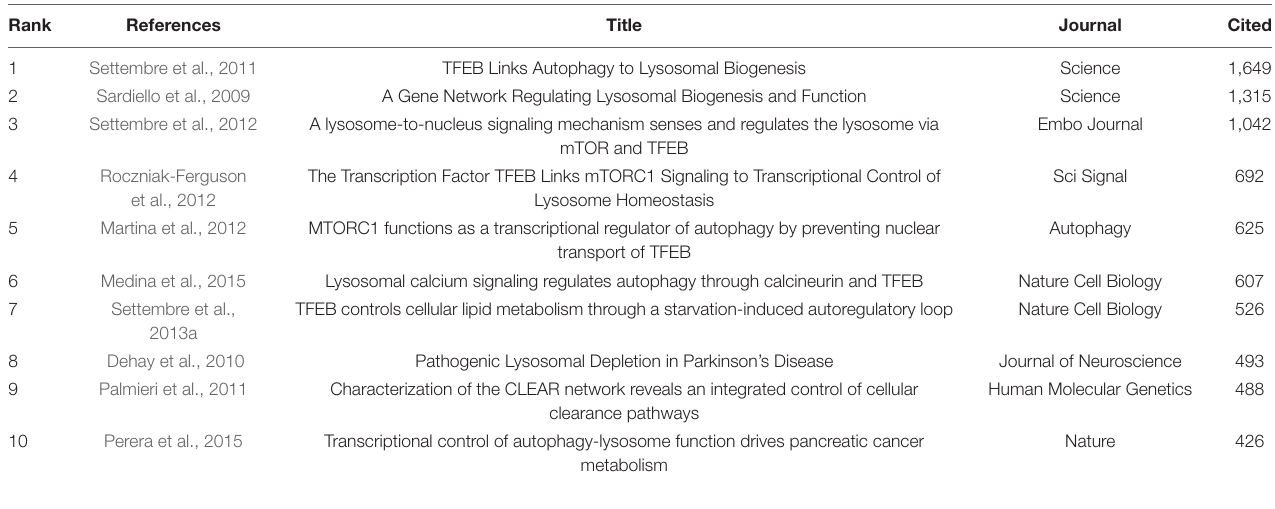
TABLE 2 | Top 10 most cited articles on